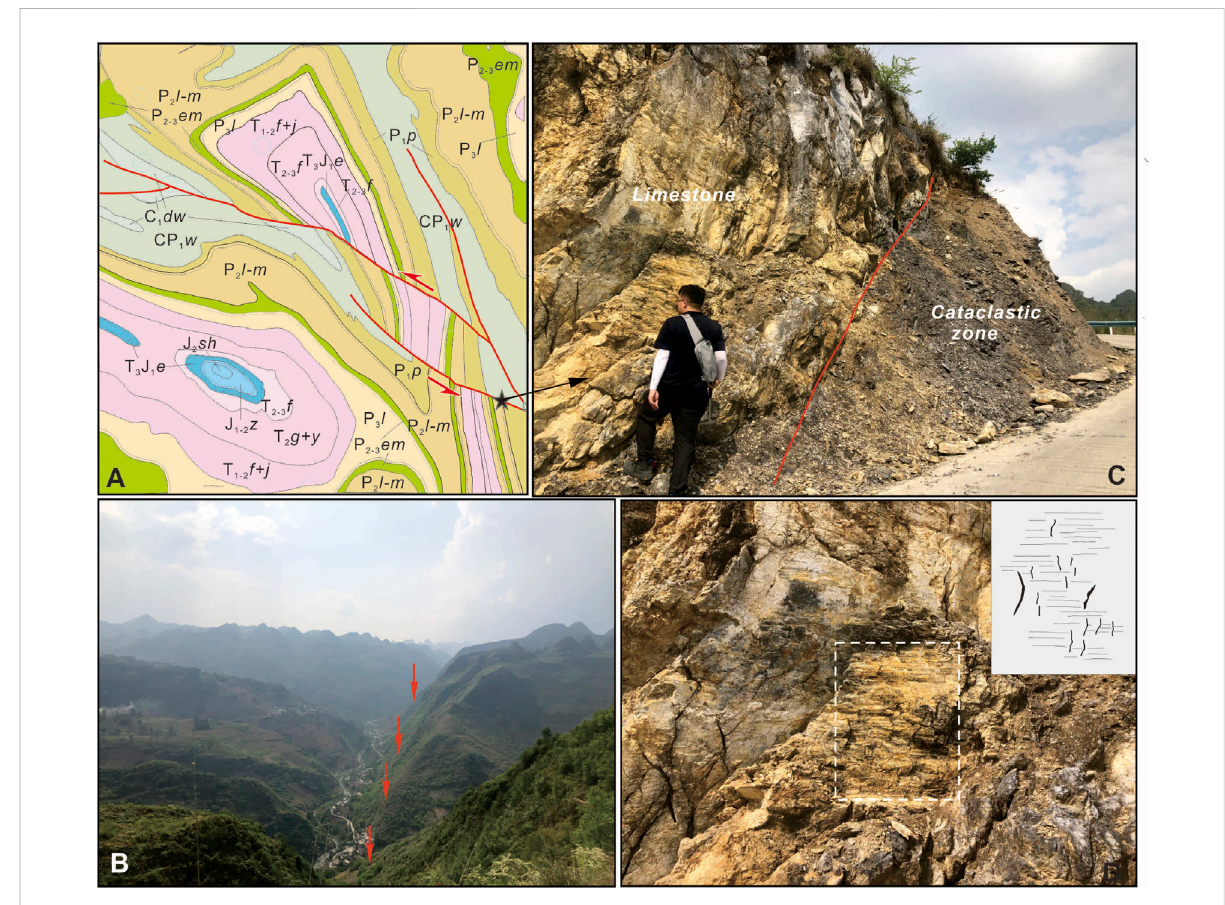
Offset geological units and typical deformation fabrics associated with sinistral strike-slip shearing. (A) Permian and Triassic strata are sinistrally displaced by 6 – 7 km along two NW-striking fault branches. (B) A linear valley and prominent fault cliffs developed along strike. (C) Penetrative fault cleavages formed in the cataclastic zone with a width of ~10 m. (D) Sub-horizontal striations and steps on the fault plane indicate sinistral strike-slip